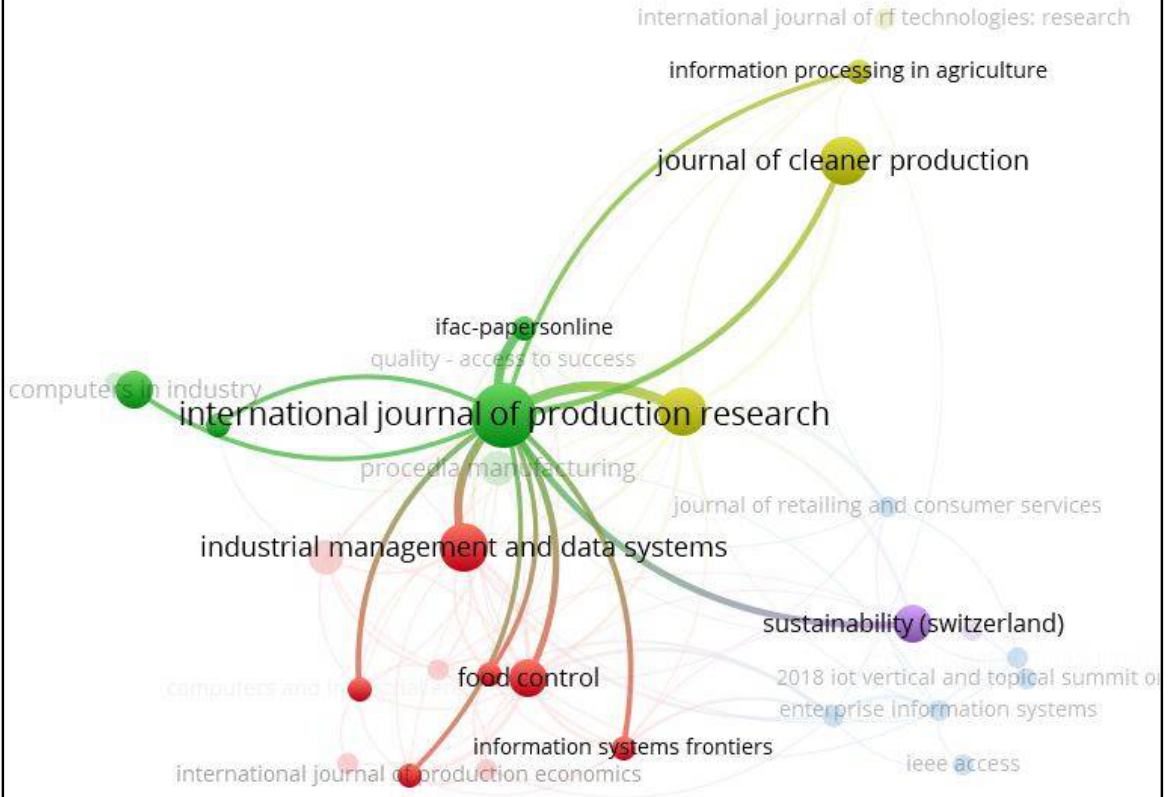
Figure 7. Bibliometric coupling of Journal Sources.